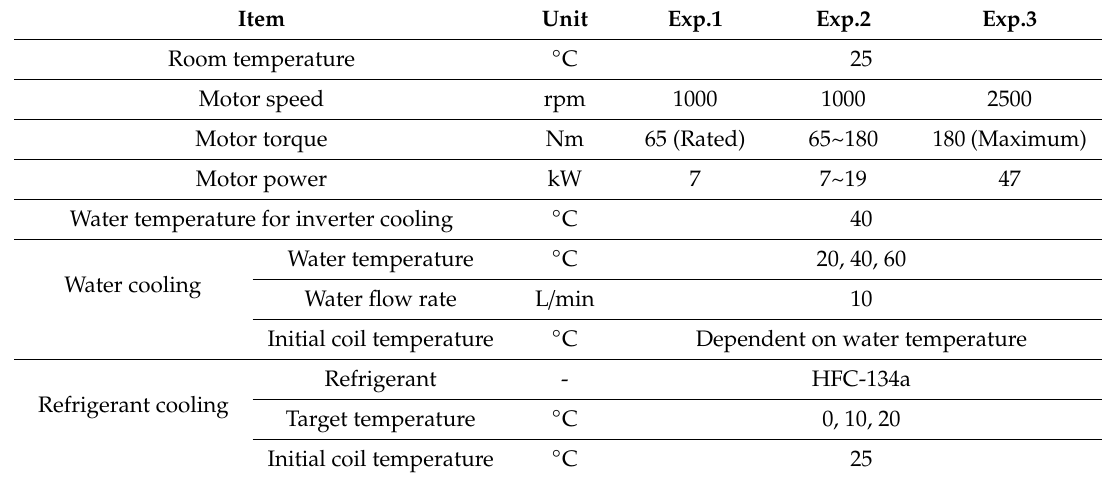
Figure 4. Experimental setup: ( a ) Water cooling; ( b ) refrigerant cooling.